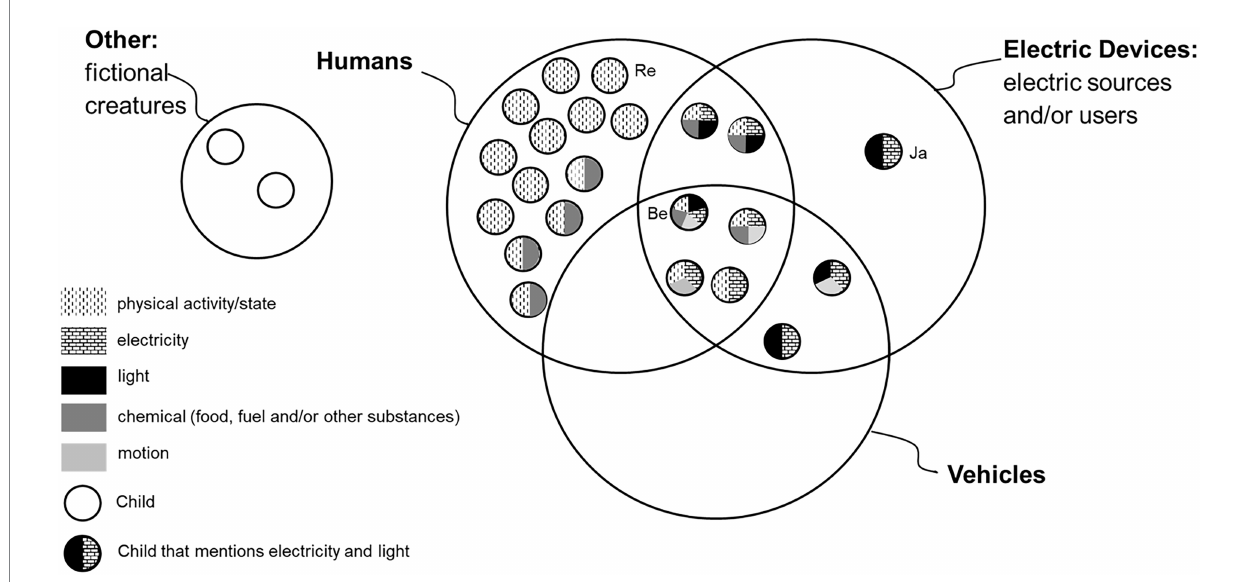
FIGURE 4 Venn diagram of the participants’ spontaneous associations with